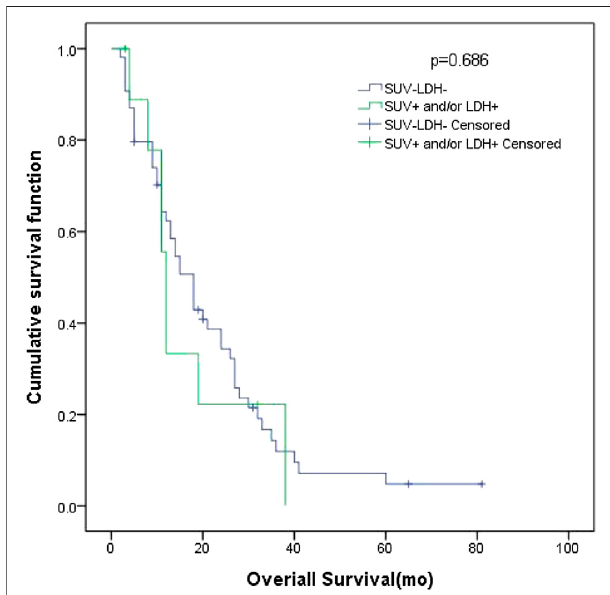
FIGURE 5 | Survival curves of SUV max of different primary tumor and LDH in 64 ED SCLC